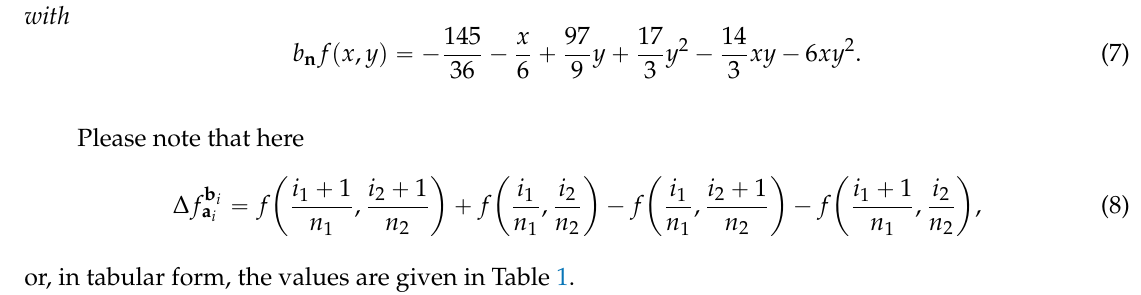
for the polynomial f i